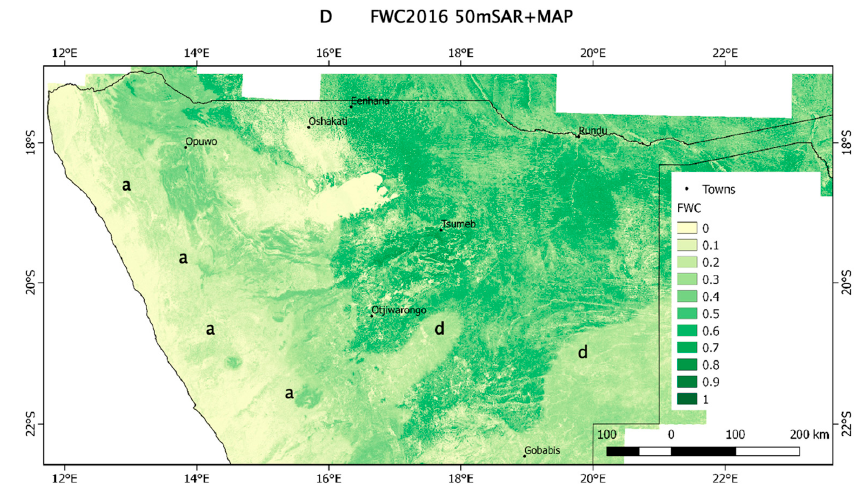
Figure 7. Fractional woody cover of northern Namibia estimated using ALOS PALSAR SAR data Figure 2016 and specified ancillary input datasets: ( A ) no ancillary data, ( B ) elevation, ( C ) elevation and MAP, and ( D ) MAP. Lower case letters on maps indicate areas with specific anomalies that are discussed in the text.